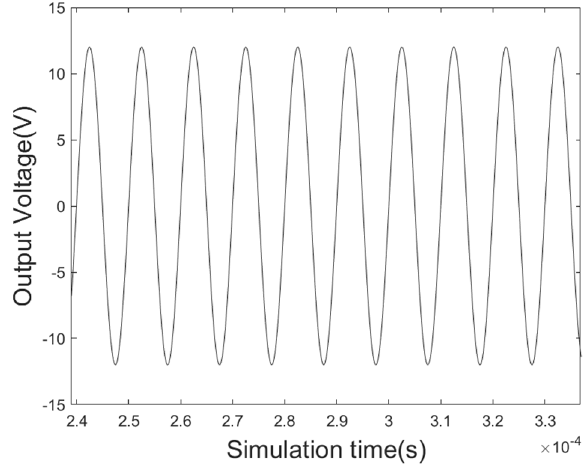
Figure 16. Voltage waveform of receiving coil output.